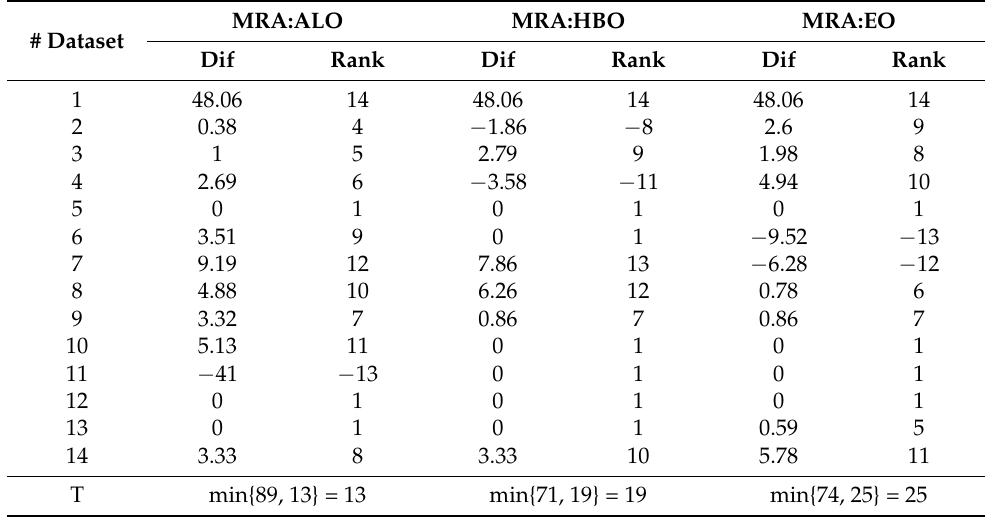
Table 5. Wilcoxon signed-rank for test F-Meas.